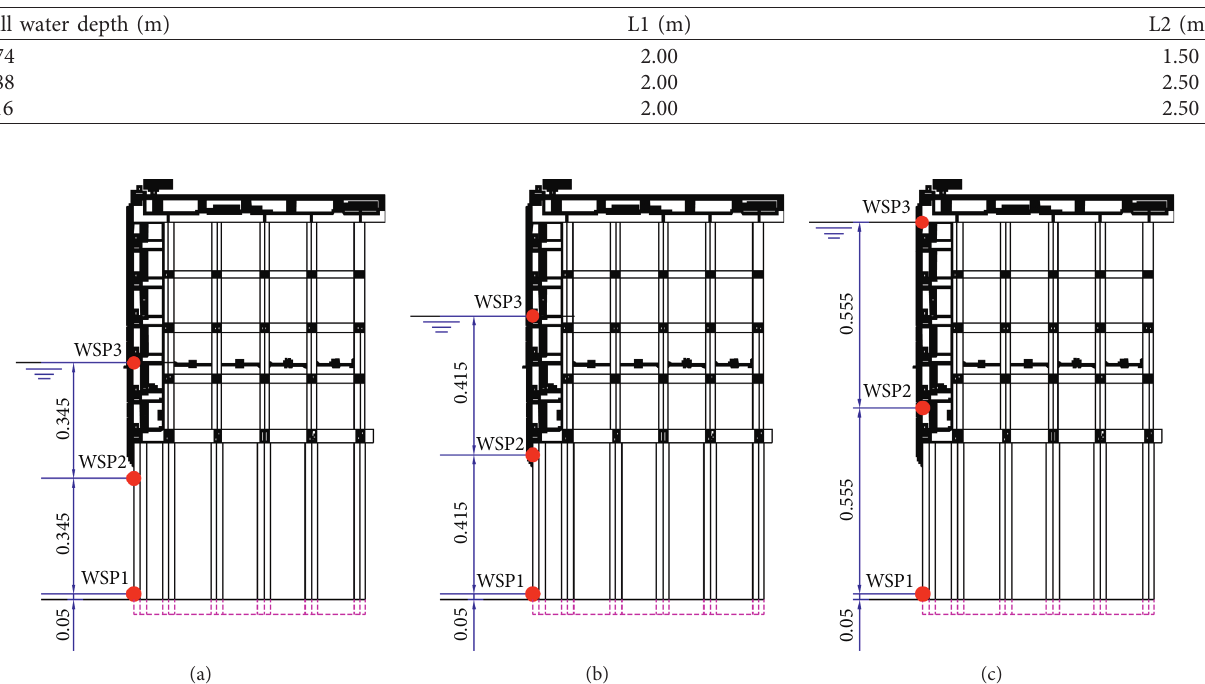
Figure 5: The experimental setup of three wave pressure sensors at different water